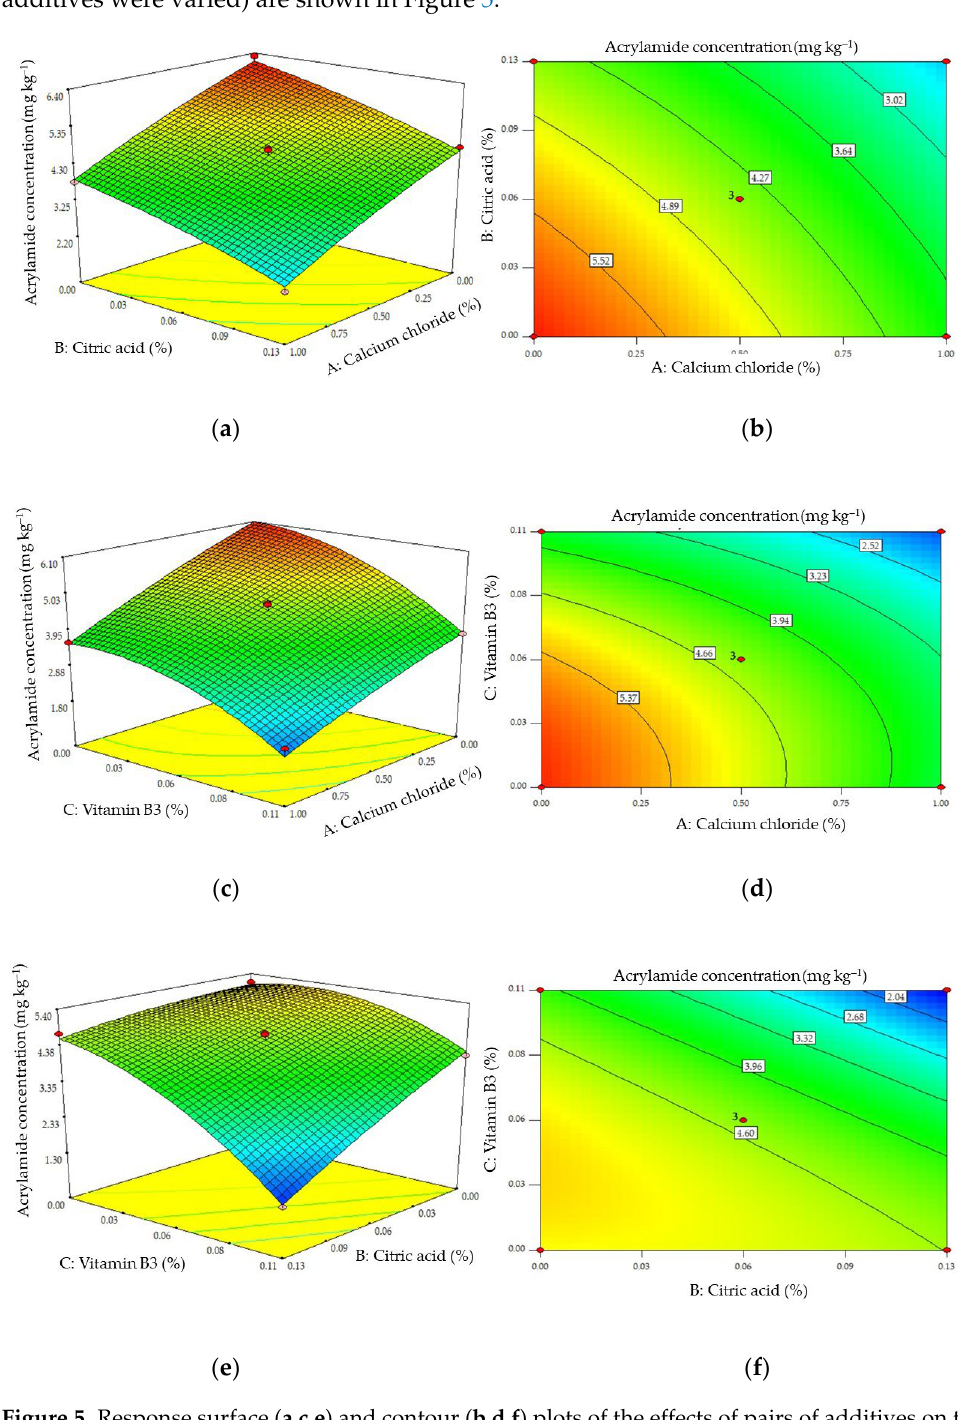
Figure 5. Response surface ( a , c , e ) and contour ( b , d , f ) plots of the effects of pairs of additives on the concentration of acrylamide formed with the concentration of the third additive at its mid - level. HMF is formed by heating under acidic conditions [26] , and it appears to be formed in all materials containing monosaccharides which are heated [27] . These findings might explain the increase in concentrations of HMF formed when the concentration of CaCl 2 was increased (Figure 6).